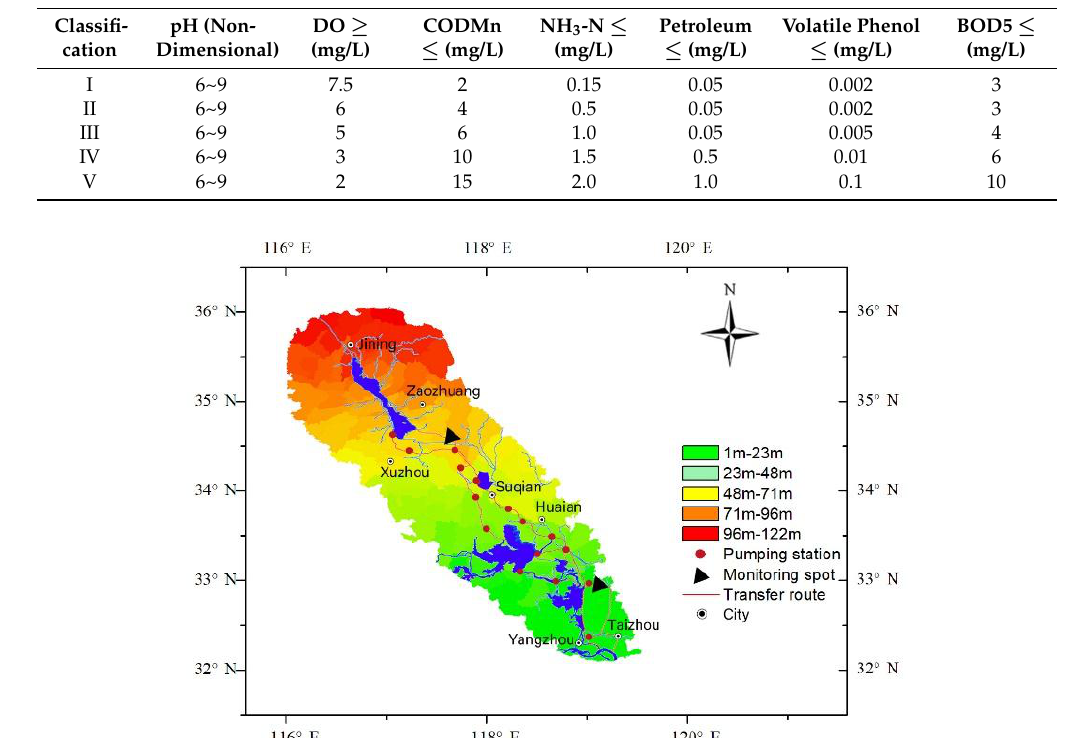
Table 1. Surface water quality standard of PRC (GB 3838-2002).